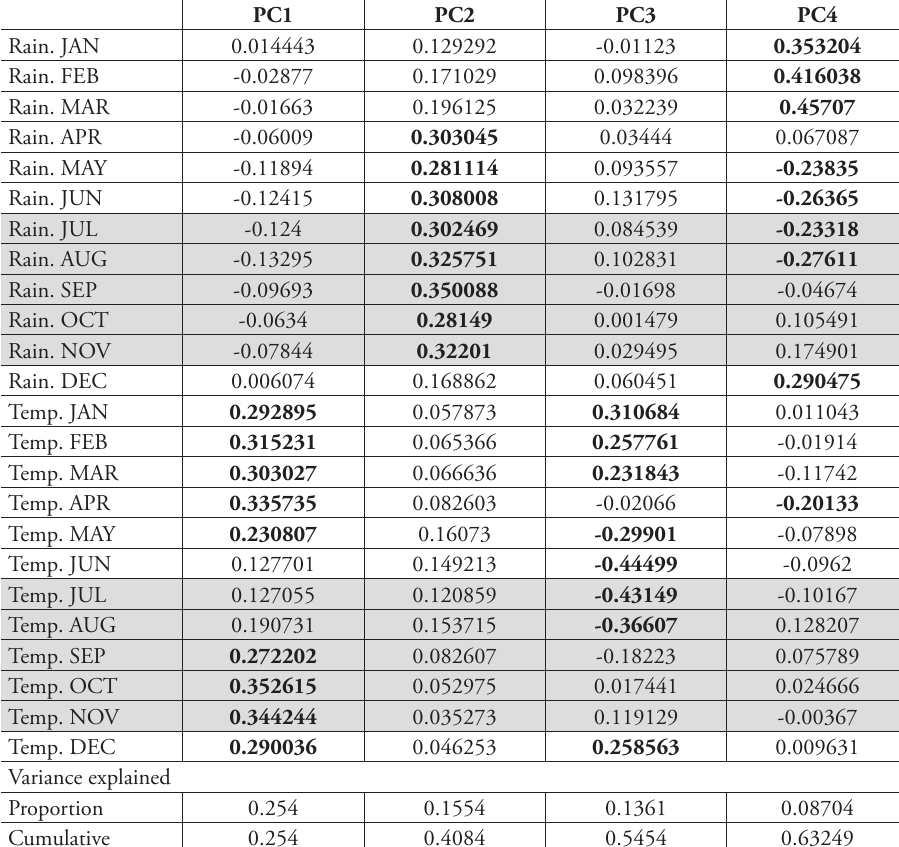
Table 1. Results of the Principal Component Analysis conducted on weather data (monthly averages of daily rainfall and daily temperatures) collected in 2000–2014 at 17 weather stations (see Figure 1). “Temp” represents the average of the daily maximum and minimum temperatures (°C), per month. “Rain” corresponds to the average of the daily rainfall (mm) per month. Variable loadings greater than 0.2 or lower than -0.2 are highlighted in bold. The months during which Black Harriers usually breed are highlighted in grey. PC1 PC2